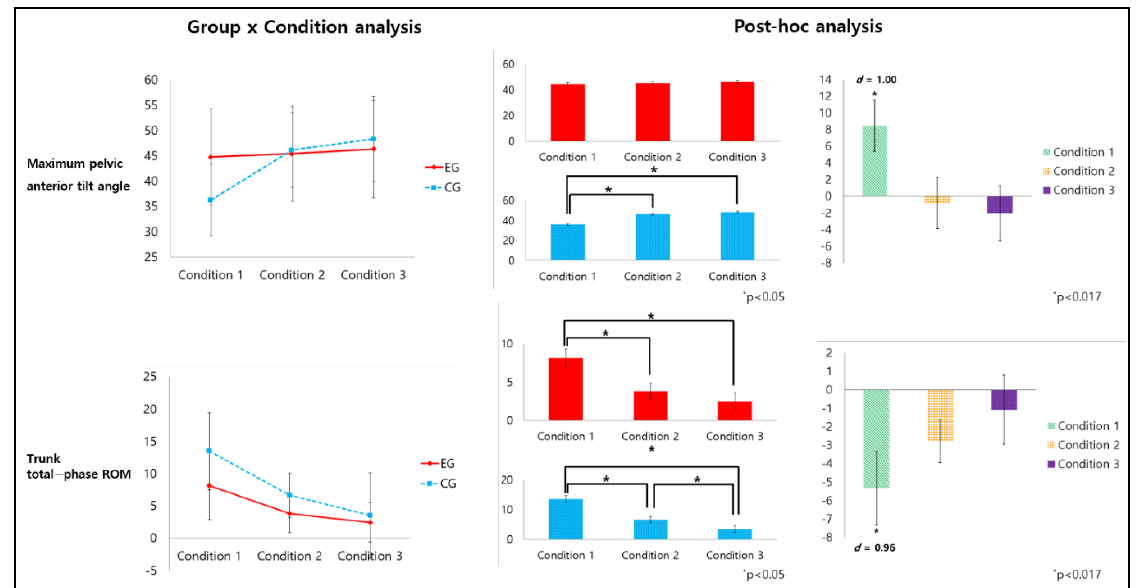
Figure 6. Interaction effects of maximum anterior pelvic tilt and total-phase ROM of the trunk.